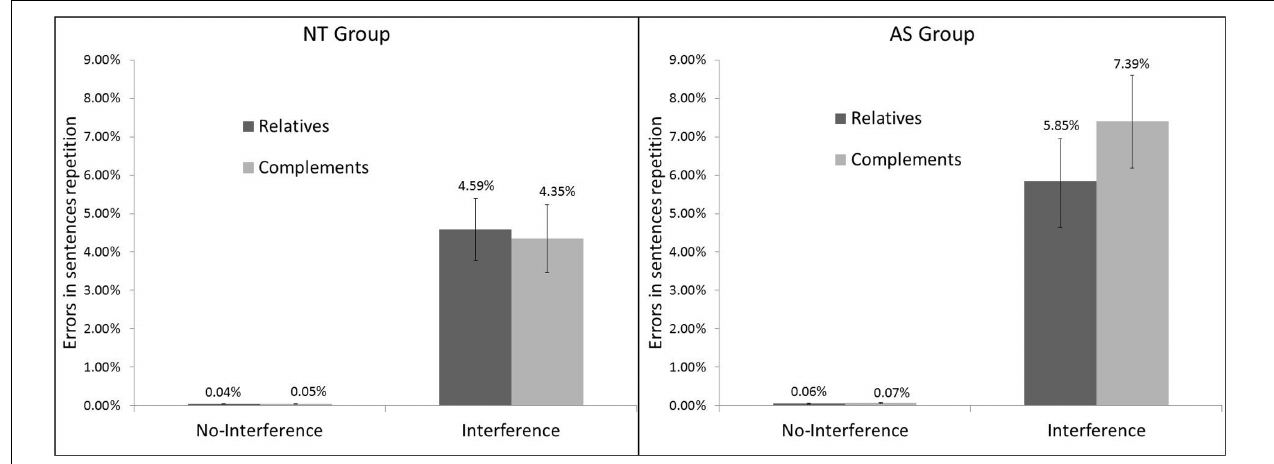
FIGURE 5 | Percentage of errors (%ER) in Sentence Repetition according to Group (NT and AS), Syntax (Relatives and Complements), and Interference phase (No-Interference and Interference).